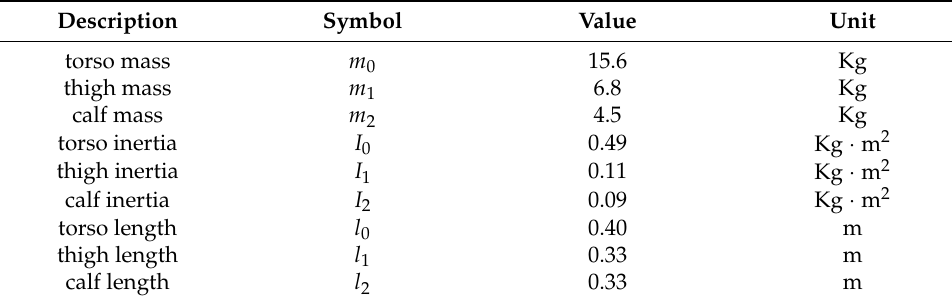
Table 1. Mechanical parameters used in the